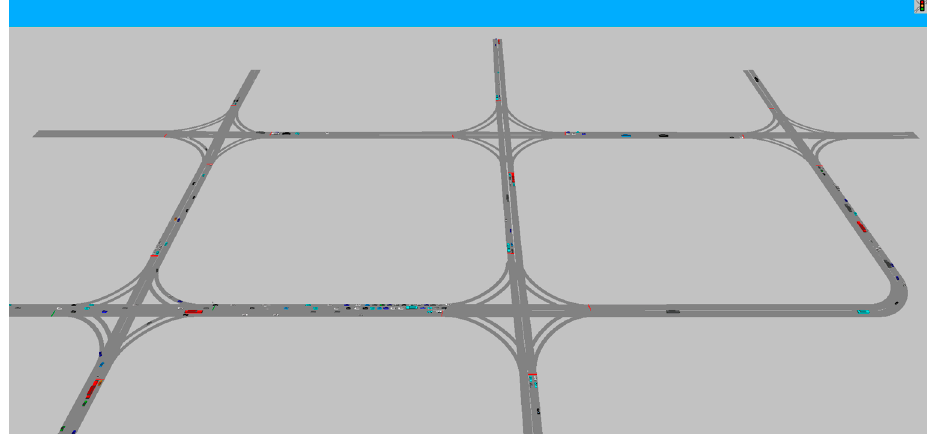
Figure 7. PTV-VISSIM (v4.3, PTV Group, Karlsruhe, Germany) simulation interface. Table 2. Number of traffic accidents of 3 cases at